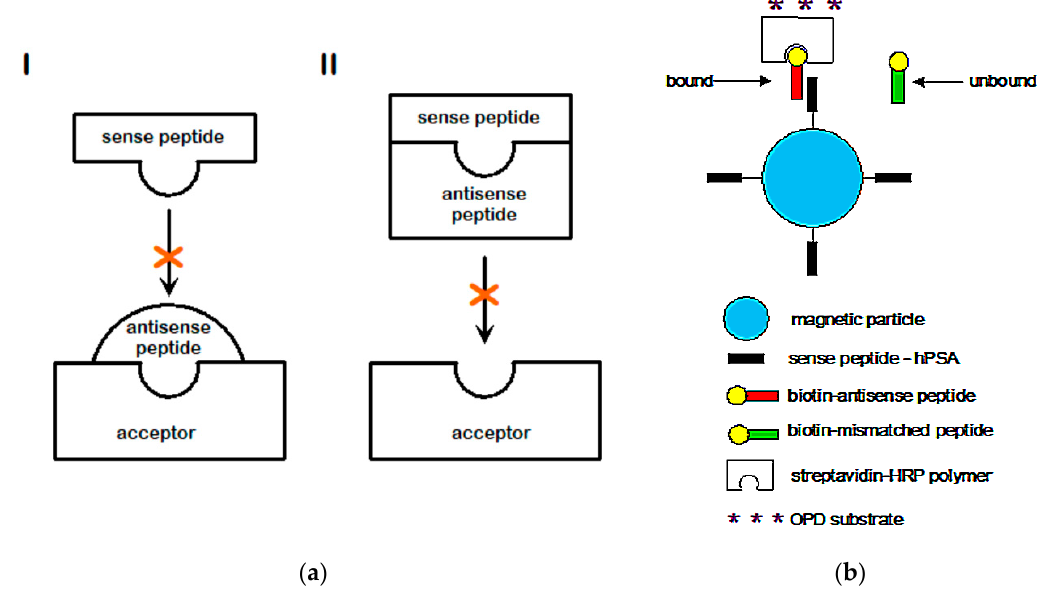
Figure 2. ( a ) Possible interactions of the complementary peptides: (I) acceptor-antisense binding, and (II) sense-antisense binding. ( b ) Schematic representation of peptide-based magnetic particle enzyme immunoassay (MPEIA) according to Štambuk et al. [20].